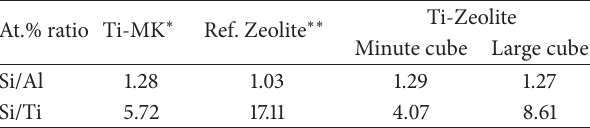
Table 4: EDX percentage of atomic constituents (At%) for starting precursor (Ti-MK), reference Zeolite, and Ti-Zeolite crystals of different